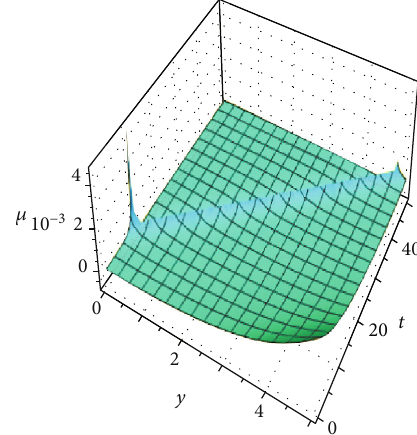
vs. space y and time t . xy